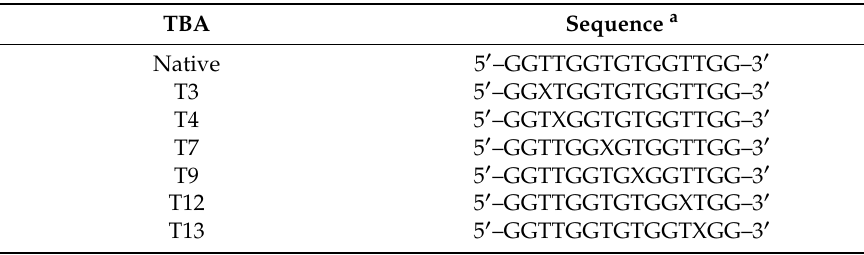
Table 1. TBA variant sequences considered in the present